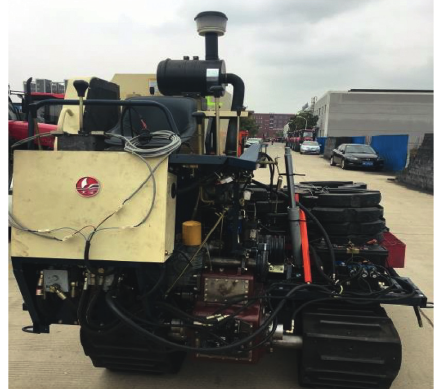
Figure 18: Bearing stability test of the crawler chassis of the combine harvester. Table 6: Rice combine harvester straight travel time (s).